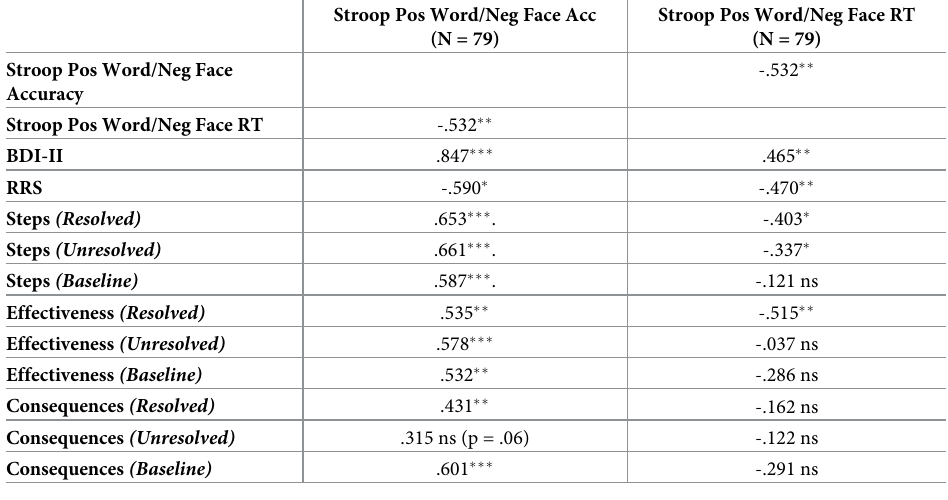
Table 5. Pearson correlation coefficients for depressed participants between Stroop performance in the positive word/negative face condition, and recall of consequences, social problem-solving and self-reported depression and